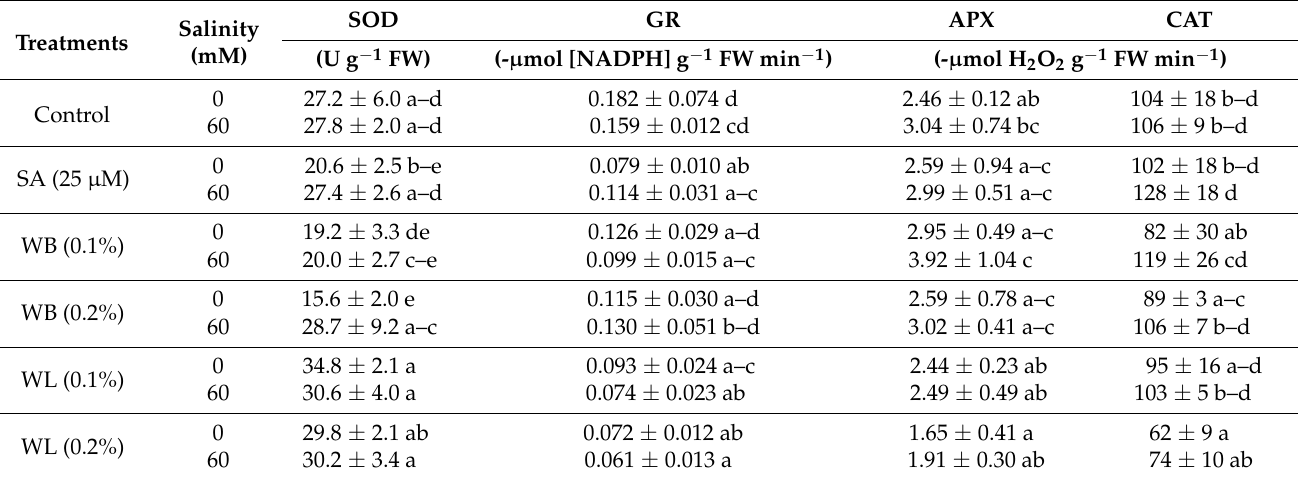
Table 3. Changes in specific activity of antioxidative enzymes (SOD, GR, APX, CAT) of 30 day-old hydroponically grown maize ( Zea mays cv. Caramelo) shoots in response to salinity (non-salinity stress, 0 mM; salinity stress, 60 mM) and biostimulant applications (SA, salicylic acid (25 µ M); WB, willow bark extract (0.1% or 0.2% w / v ); WL, willow leaf extract (0.1% or 0.2% w/v )).